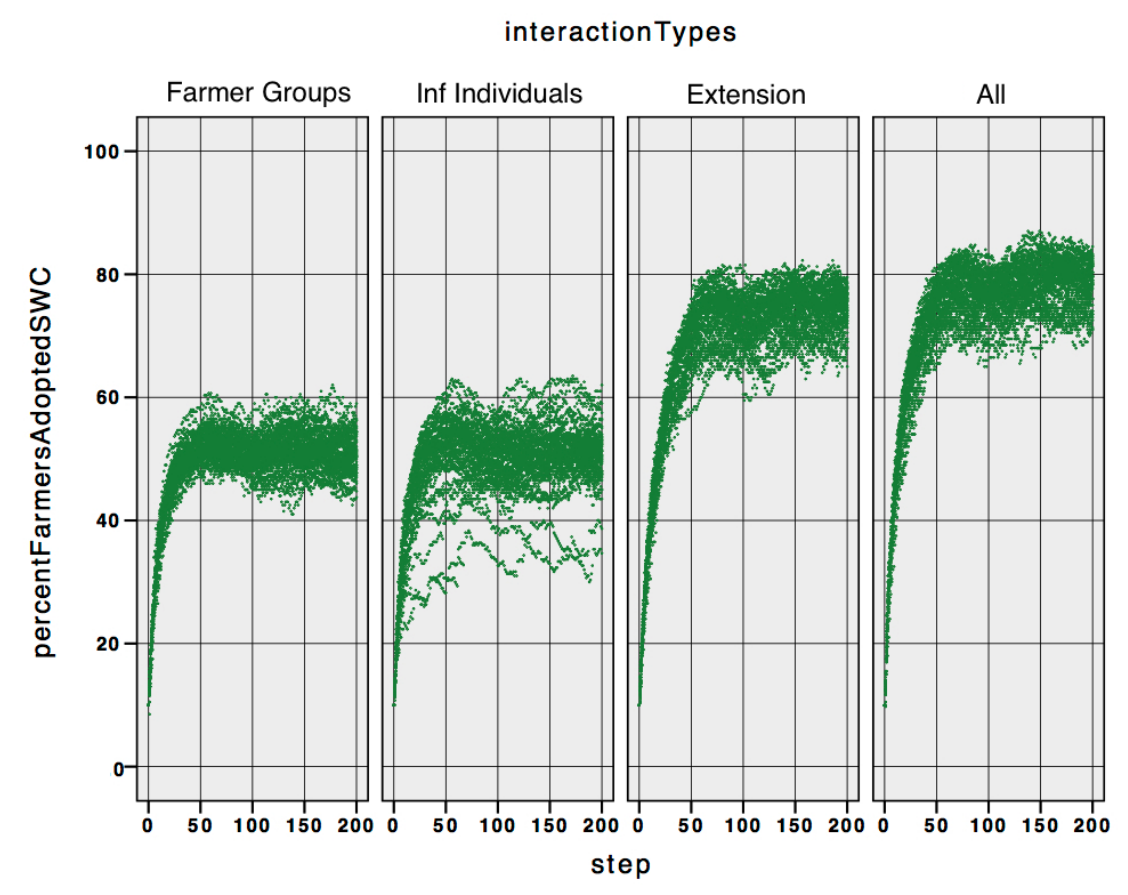
Figure 4. An example of model results shown to the participants: this graphs shows the percent of farmers adopting SWC under different interaction type scenarios for multiple runs of the